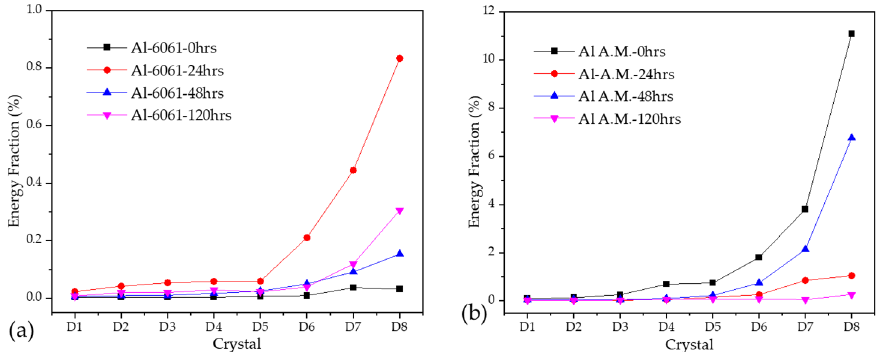
Figure 12. Wavelets in the H 2 O solution ( a ) Al-6061 and ( b ) Al-A.M.